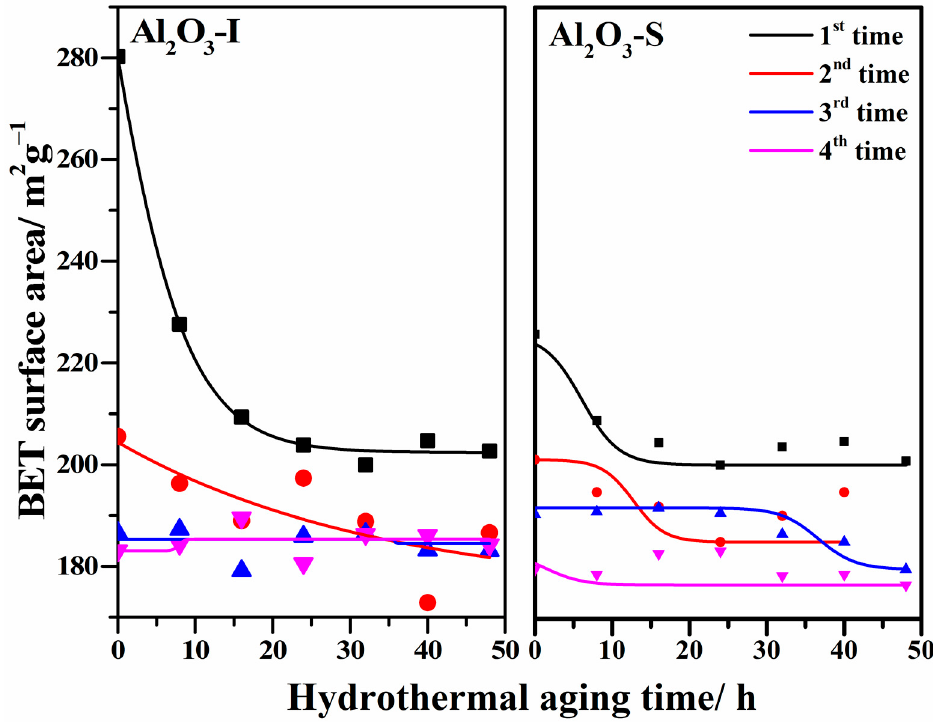
Figure 7. BET specific surface area variation in Al 2 O 3 -I and Al 2 O 3 -S after one to four cases of hydrothermal treatment under water vapor at 600 ◦ C for 48 h (one cycle).